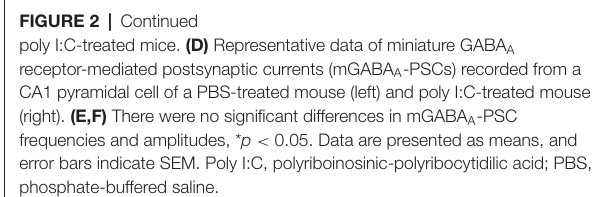
FIGURE 2 | Continued poly I:C-treated mice. (D) Representative data of miniature GABA A receptor-mediated postsynaptic currents (mGABA A -PSCs) recorded from a CA1 pyramidal cell of a PBS-treated mouse (left) and poly I:C-treated mouse (right). (E,F) There were no significant differences in mGABA A -PSC frequencies and amplitudes, * p < 0.05. Data are presented as means, and error bars indicate SEM. Poly I:C, polyriboinosinic-polyribocytidilic acid; PBS, phosphate-buffered